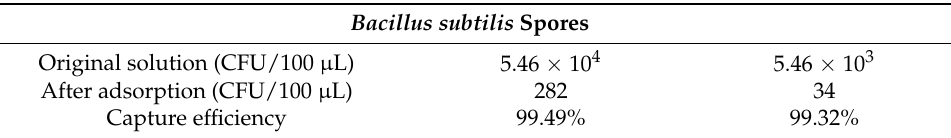
Table 1. Magnetic capture efficiency of Fe 3 O 4 @PDA@PEI MBs for Bacillus subtilis . Bacillus subtilis Spores